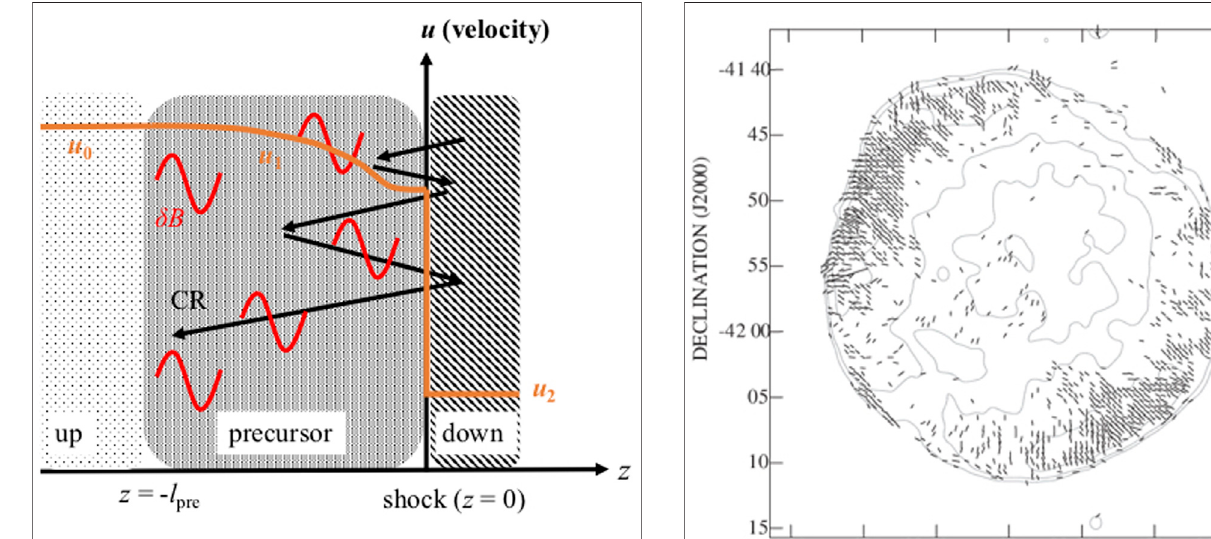
FIGURE 1 | Schematic illustration of the CR accelerating shock. The plane-parallel shock is located at z = 0. The velocity of fl uid u ( z ) is represented by orange line. The black allows indicate the trajectory of the accelerating CR which is bouncing back and force between the upstream and downstream region. The red curves show magnetic disturbances δ B which are generated by the CRs or pre-existing in the ISM. The CR well con fi ned region is referred to the precursor and the thickness of the precursor is l pre . The structure of the fl uid velocity is modi fi ed by the CR pressure before entering the shock front. Reproduced from Shimoda and Laming (2019).